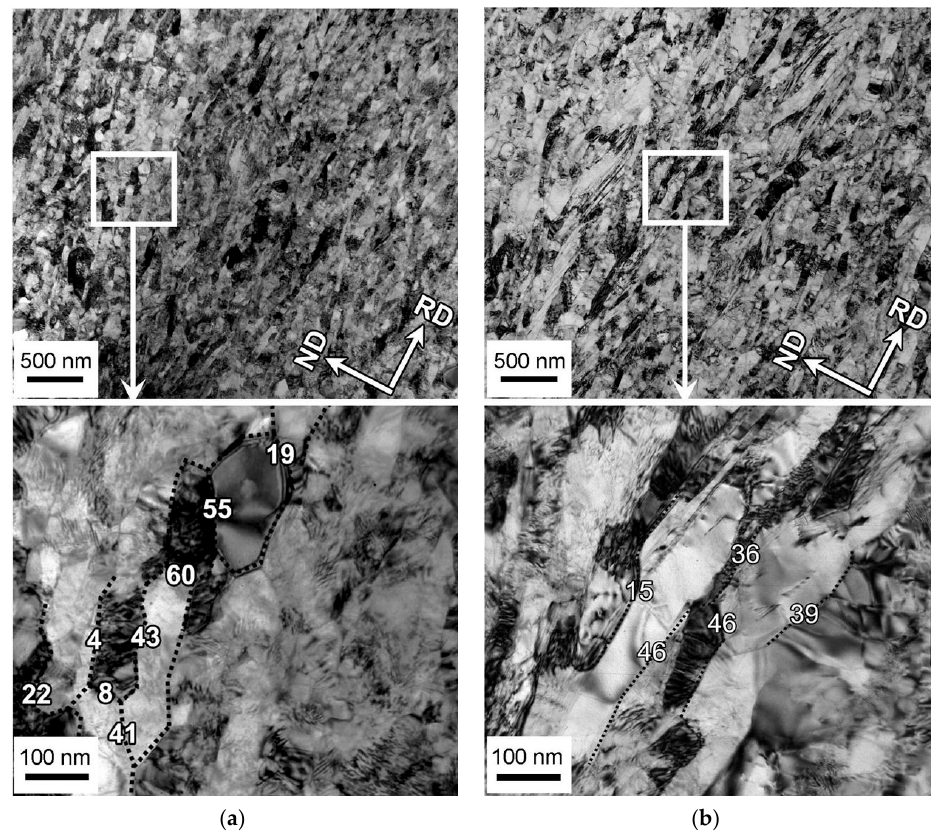
min at 973 K are represented in Figure 3. The austenite reversal and a kind of continuous